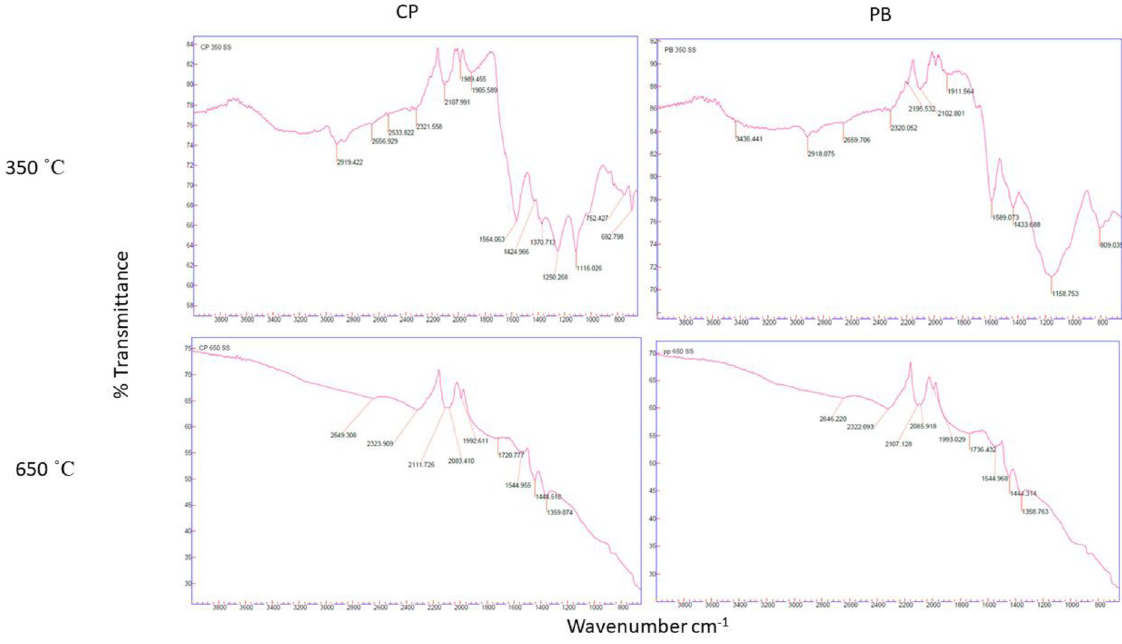
Fig 1. FTIR spectra visible of 4 studied biochars at different pyrolysis temperature using FTIR. CP = cull potato waste; PB = pine bark.